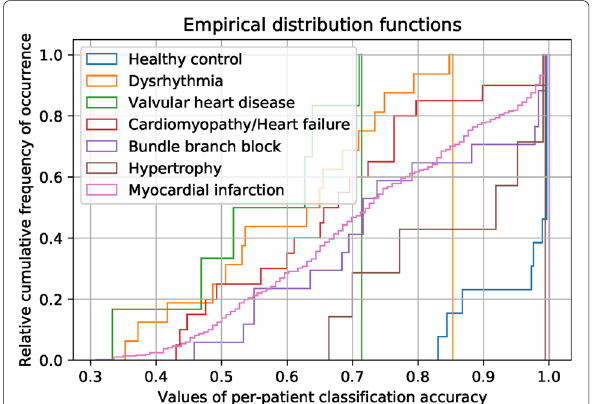
Fig. 5 Distribution of per-patient classification accuracy evaluated on test patients from different categories